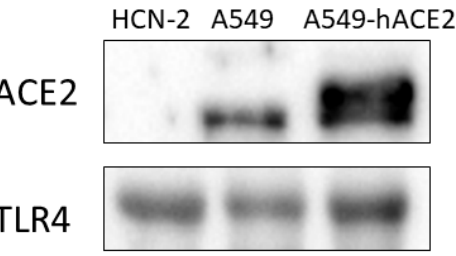
Figure 3. Western blot for ACE2 and TLR4. HCN-2 cells expressed TLR4 but not ACE2. A549 and A549-hACE2 expressed ACE2 and